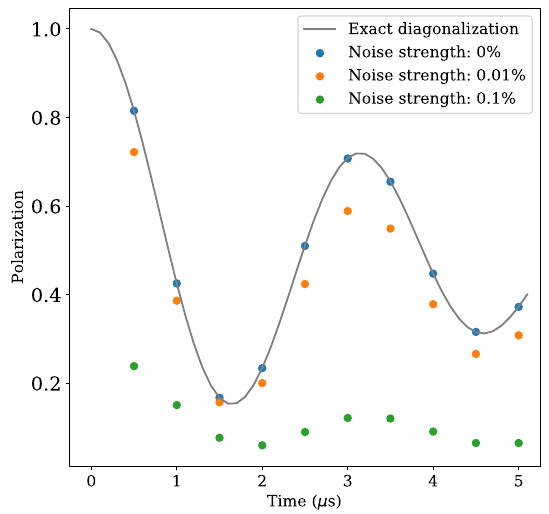
FIG. 12. Density-matrix simulations of the three qubit F- μ + -F system, with single-qubit depolarizing noise applied after each gate. The noise channel is applied independently to each qubit involved in the gate. The simulation used 20 second-order Trotter steps, which yield a circuit with 900 single-qubit gates, and 680 two-qubit